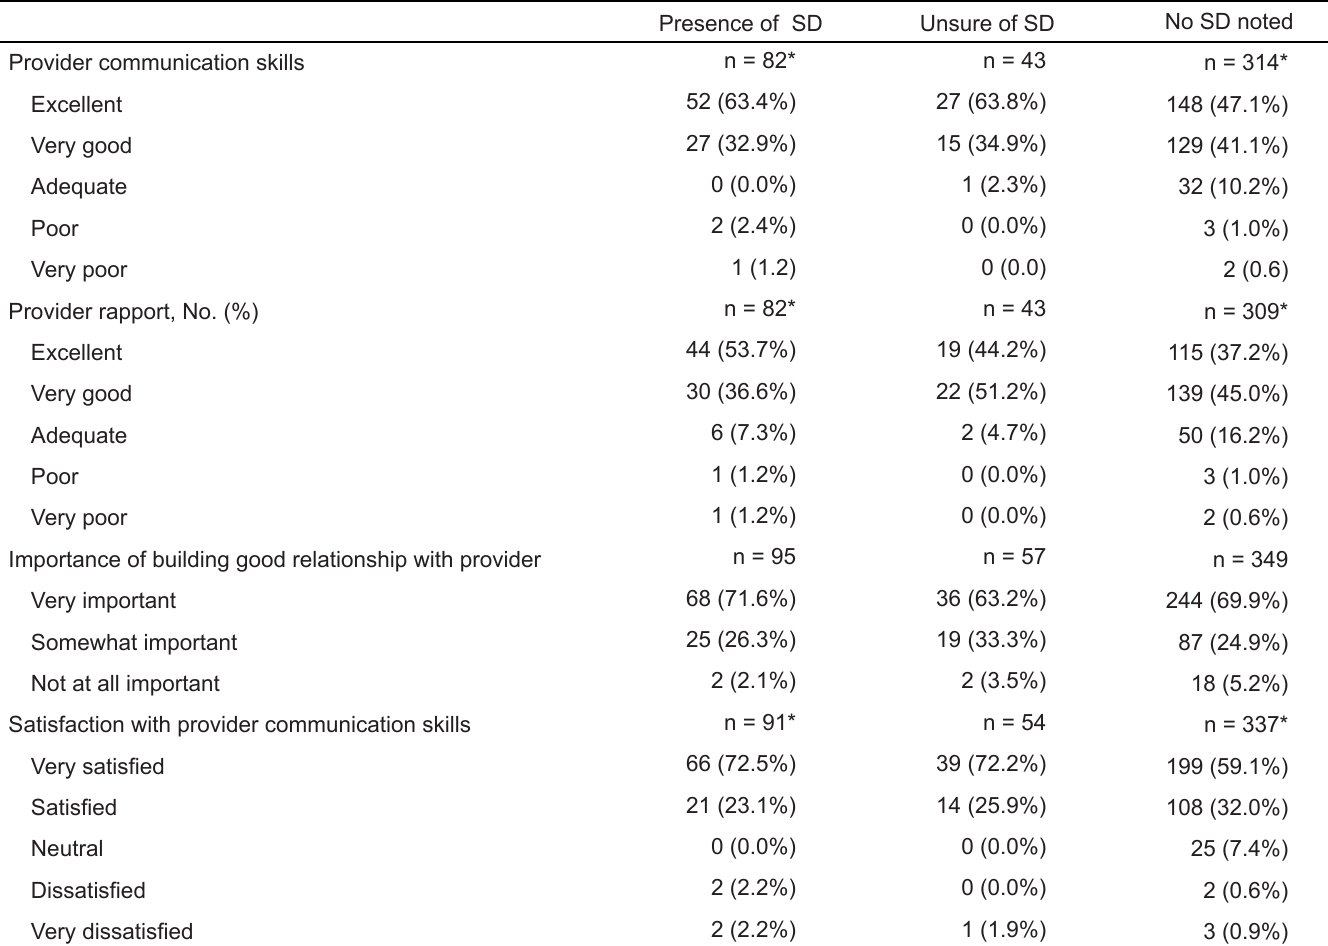
Table 1. Patient ratings of provider interaction in the emergency department (SD =